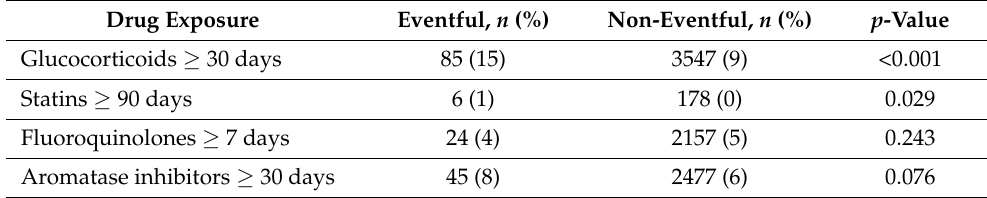
Table 4. The association of drug exposure and development of tendon